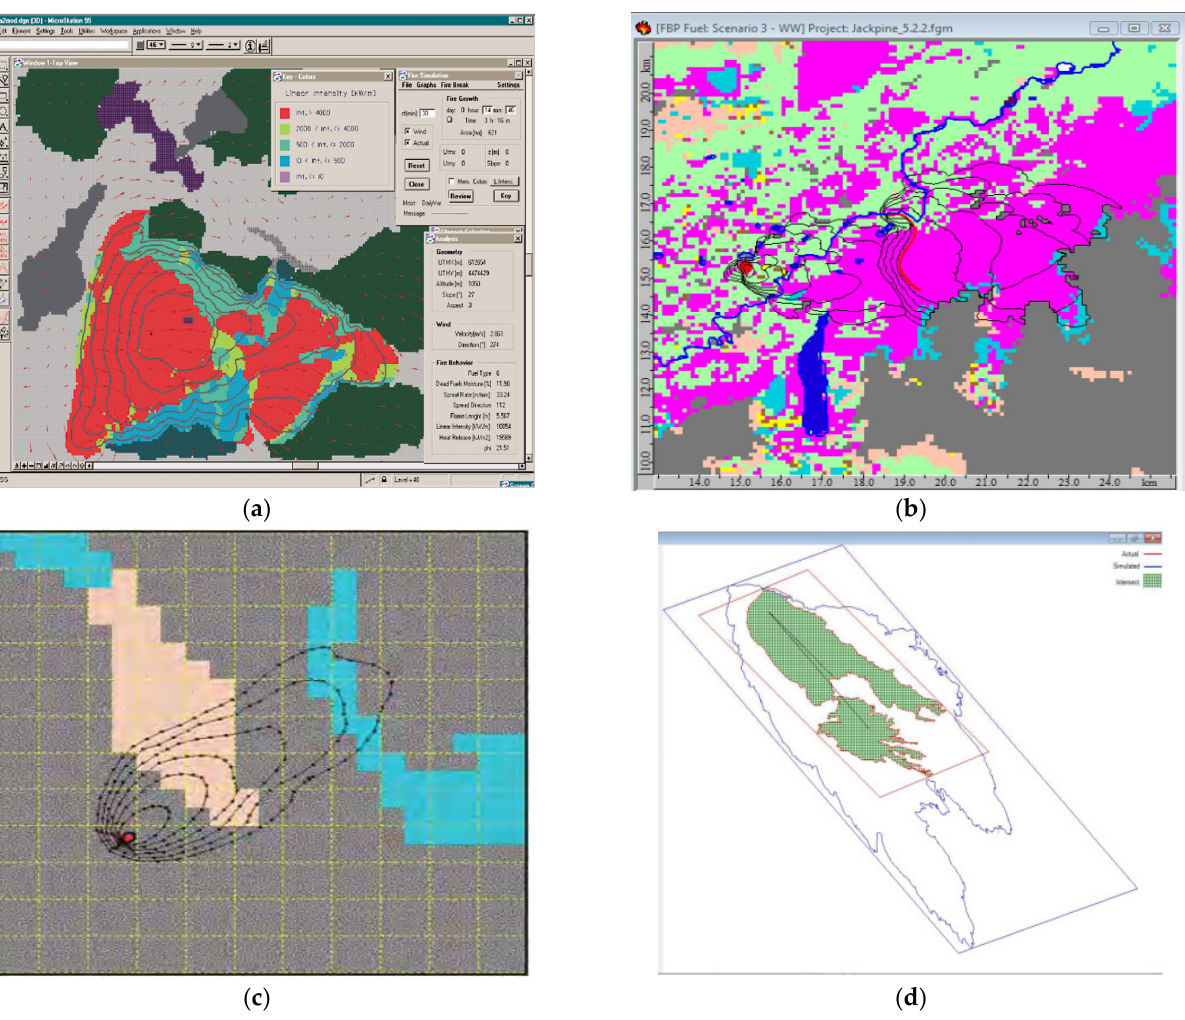
Figure 2. Examples of different fire simulation snapshots. ( a ) Screenshot of fireStation software: following fire growth model. The major view draws the fuel map with the modeled fire strength. The vectors show the wind area, the length being proportional to the wind velocity [60]. ( b ) Screenshot of the Prometheus software: Fire Growth Simulation Model user interface. Image courtesy of Alberta Sustainable Resource Development [88]. ( c ) 35 min modeling results in the Prometheus Map view applying a distance resolution of one grid cell [44]. ( d ) Screengrab of fire simulation from Phoenix RapidFire 4.008 (Melbourne). The fire field is shown as a green polygon, the modeled fire field is shown as a blue polygon